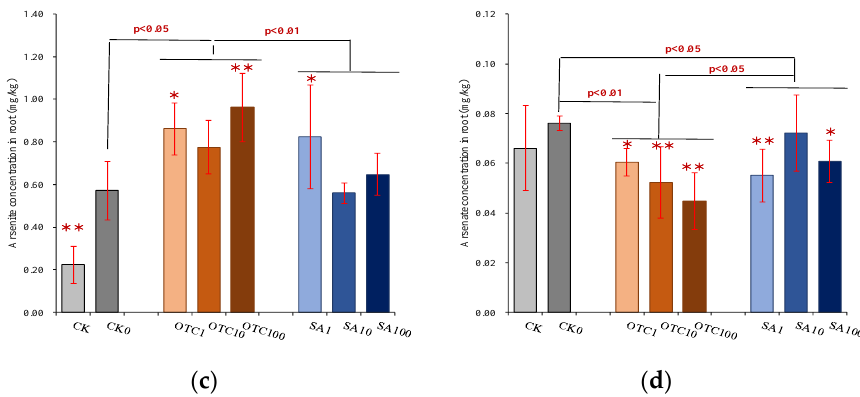
Figure 3. Changes in arsenic mobilization of rhizosphere soil in different treatments. ( a ) Arsenite concentration in soil; ( b ) Arsenate concentration in soil; ( c ) Arsenite concentration in root; ( d ) Arsenate concentration in root. CK is the soil without manure-based fertilizer; CK0 shows the soil with manure-based fertilizer at 0 mg/kg antibiotic concentration; OTC1 is the soil with manure-based fertilizer at 1 mg/kg OTC concentration; OTC10 is the soil with manure-based fertilizer at 10 mg/kg OTC concentration; OTC100 is the soil with manure-based fertilizer at 100 mg/kg OTC concentration; SA1 is the soil with manure-based fertilizer at 1 mg/kg SA concentration; SA10 is the soil with manure-based fertilizer at 10 mg/kg SA concentration; SA100 is the soil with manure-based fertilizer at 100 mg/kg SA concentration. * or ** represents significant differences ( p < 0.05 or p < 0.01) between each antibiotic treatment (e.g., OTC1, OTC10) and CK0; and p < 0.05 or p < 0.01 on the line represents significant differences between treatment groups such as control, OTC, and SA treatments.